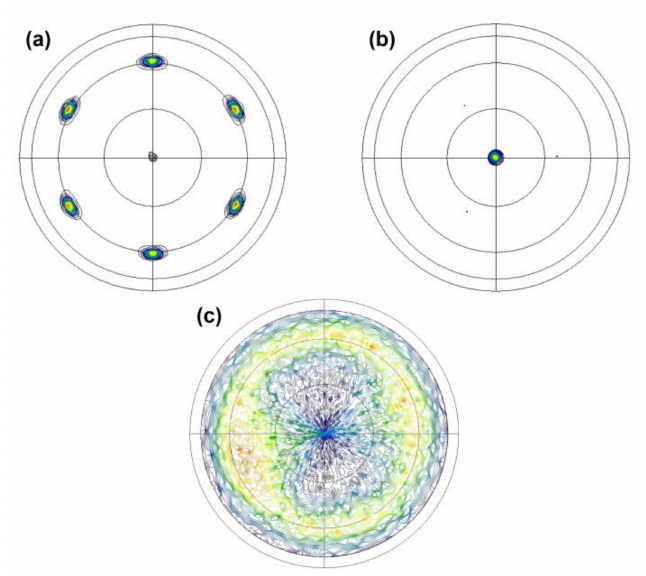
Figure 4. XRD pole figure pattern of ( a ) AlN (101) from the AlN thin film on the Mo/sapphire substrate, ( b ) AlN (002) from the AlN thin film on the Mo/sapphire substrate, and ( c ) AlN (101) from the AlN thin film on the Mo/SiO 2 /Si